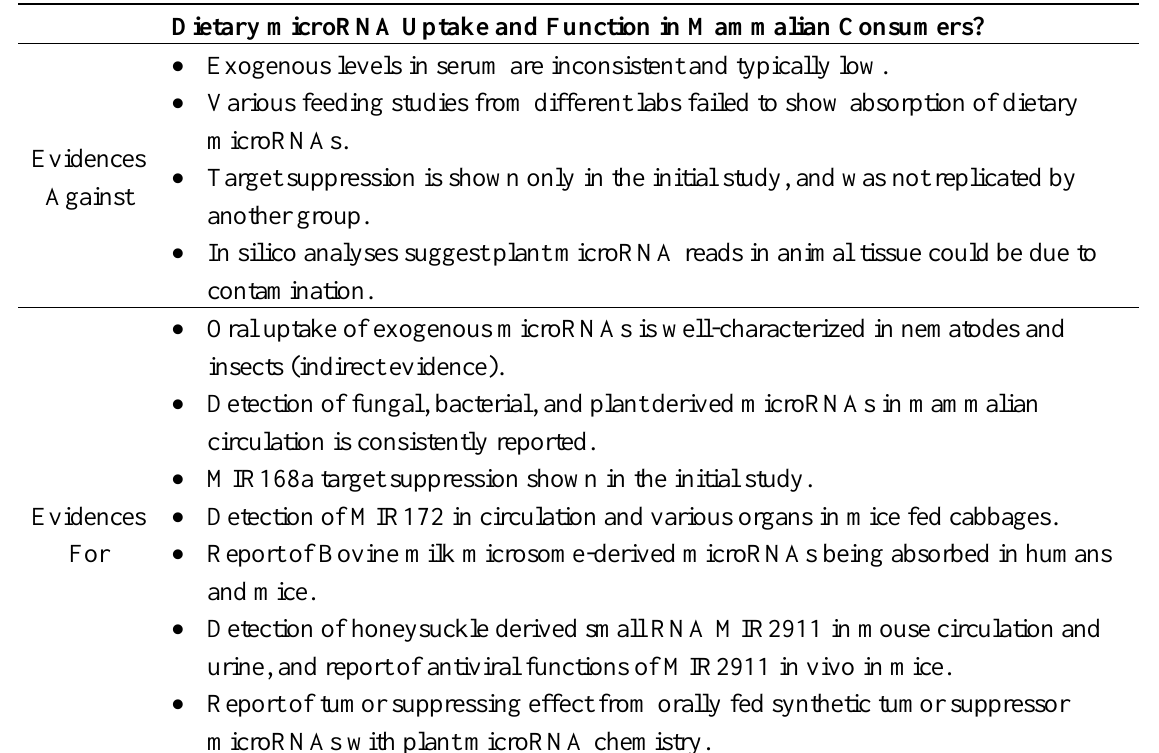
Table 2. Summary of evidence regarding dietary microRNA uptake and functionality in